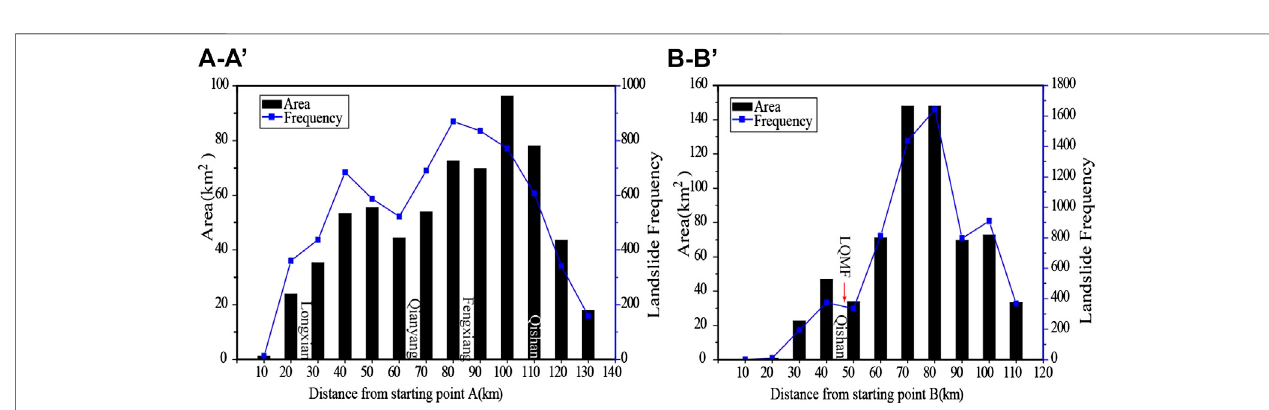
FIGURE 4 | Frequency and cumulative area along strike and vertical strike of the Long xian – Qishan – Mazhao Fault (10 km) (Projection lines A – A ′ and B – B ′ are shown in Figure 2 ).